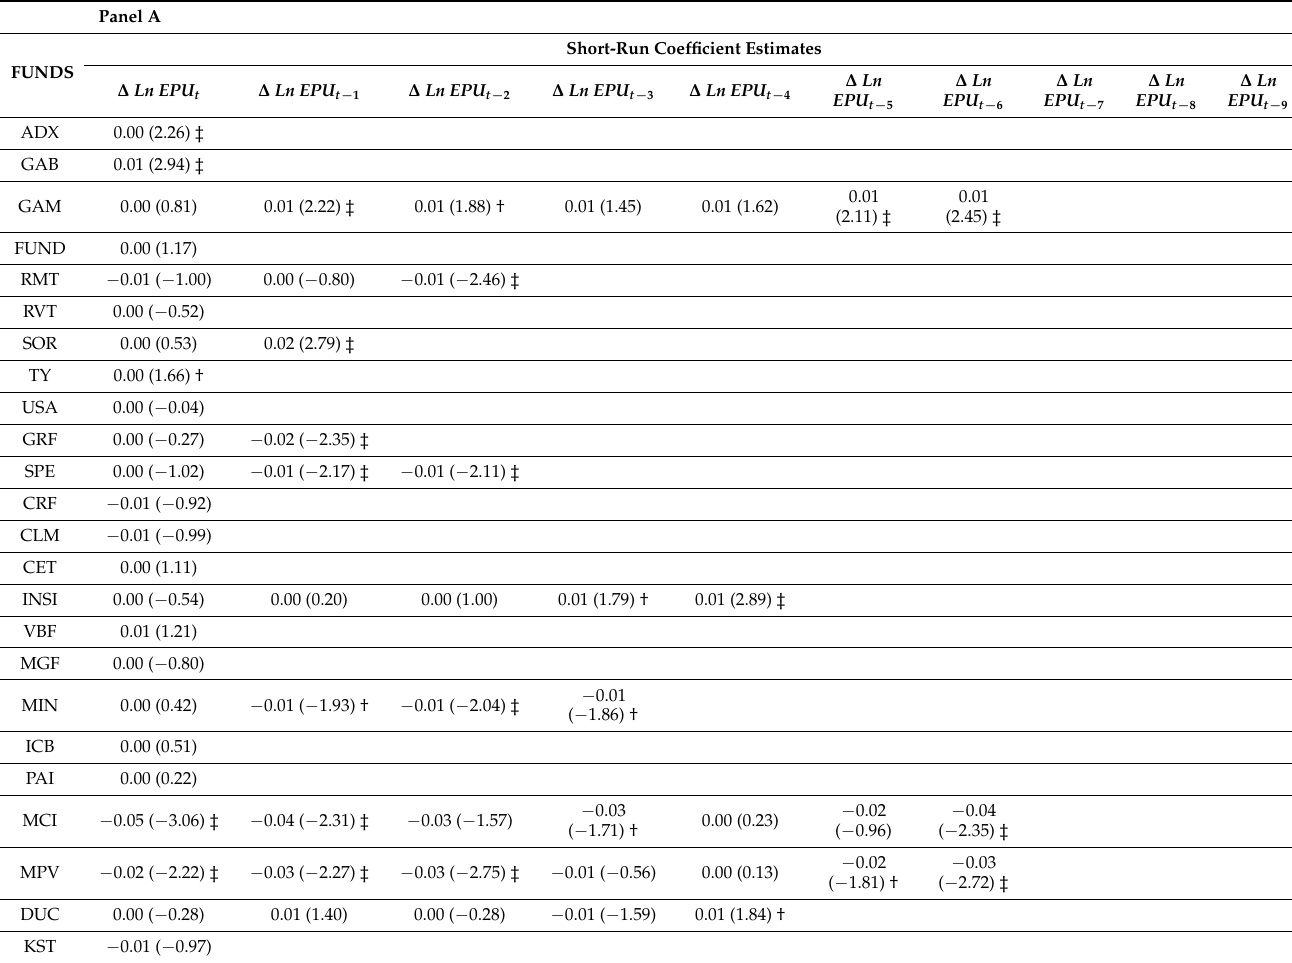
Table 1. Short-Run Coefficient Estimates—Linear ARDL—Model P = f (NAV,